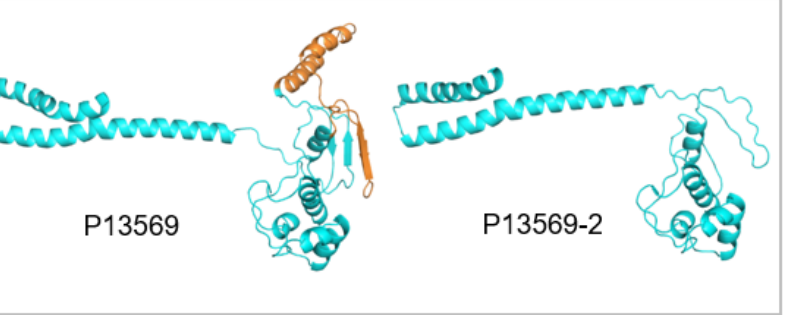
Figure 8. Ribbon representation of AlphaFold models of canonical proteins (left) and their isoforms (right). Fragments of canonical proteins deleted in the isoforms are in orange. Fragments of isoforms that substitute deleted fragments of the canonical proteins are in magenta. Representative structures of each subgroup from top to bottom are: ( A ). Deletions preserving the overall structure. Q7RTR2, LRR-protein of NLR family CARD domain-containing protein 3; P16520, 7-bladed beta-propeller of Guanine nucleotide-binding protein G(I)/G(S)/G(T) subunit beta-3. AlphaFold model of isoform represents 6-bladed structure with an open beta-propeller, SwissModel structure made based on the known 6-bladed structure (PDB code 1E1A) has closed beta-propeller; O94856, neurofascin; O95259, potassium voltage-gated channel subfamily H member 1; ( B ). Substitutions preserving the structure. P11362, fibroblast growth factor receptor 1; ( C ). Deletions replaced by another part of the protein. O00762, ubiquitin-conjugating enzyme E2 C, on the right, in yellow, the known crystal structure of ubiquitylation module similar to the truncated structure of the isoform in the center; ( D ). Deletions destabilizing structured domains. P13569, cystic fibrosis transmembrane conductance